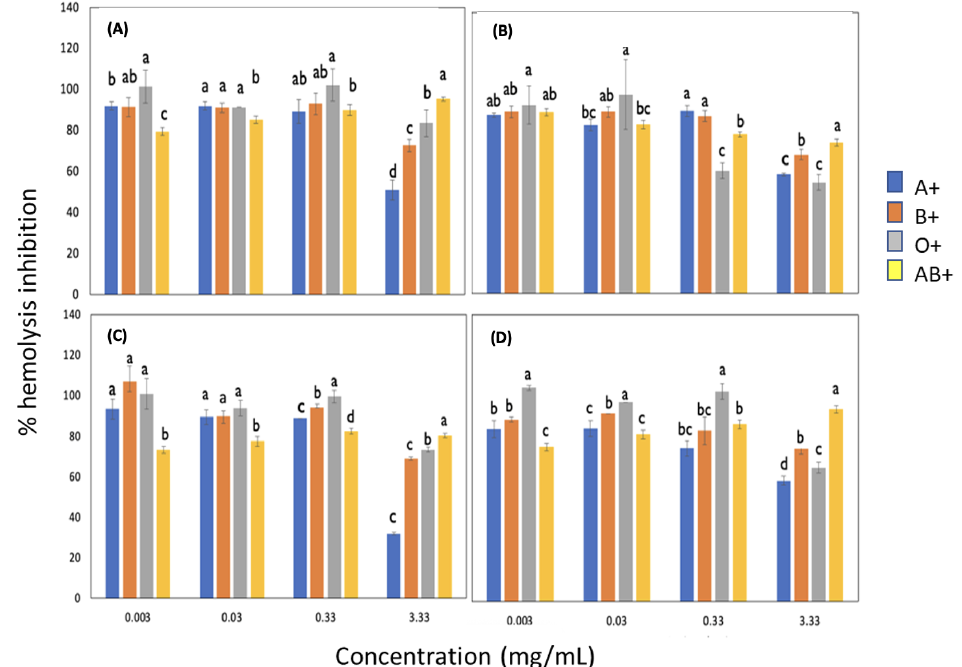
Figure 2. Effect of blood groups with different Rh in inhibiting free radicals induced by AAPH in lignin with and without pulses. ( A ) Lignin with 0/0 time (min)/amplitude (MHz), ( B ) Lignin with 10/14 time (min)/amplitude (MHz), ( C ) Lignin with 10/18 time (min)/amplitude (MHz), ( D ) Lignin with 10/20 time (min)/amplitude (MHz). Different letters indicate significant difference ( p < 0.05). The study carried out by Shabbir et al. [27] studied fractions of M. royleanus . It showed that the lysis of the erythrocytes increased concomitantly with the concentration of